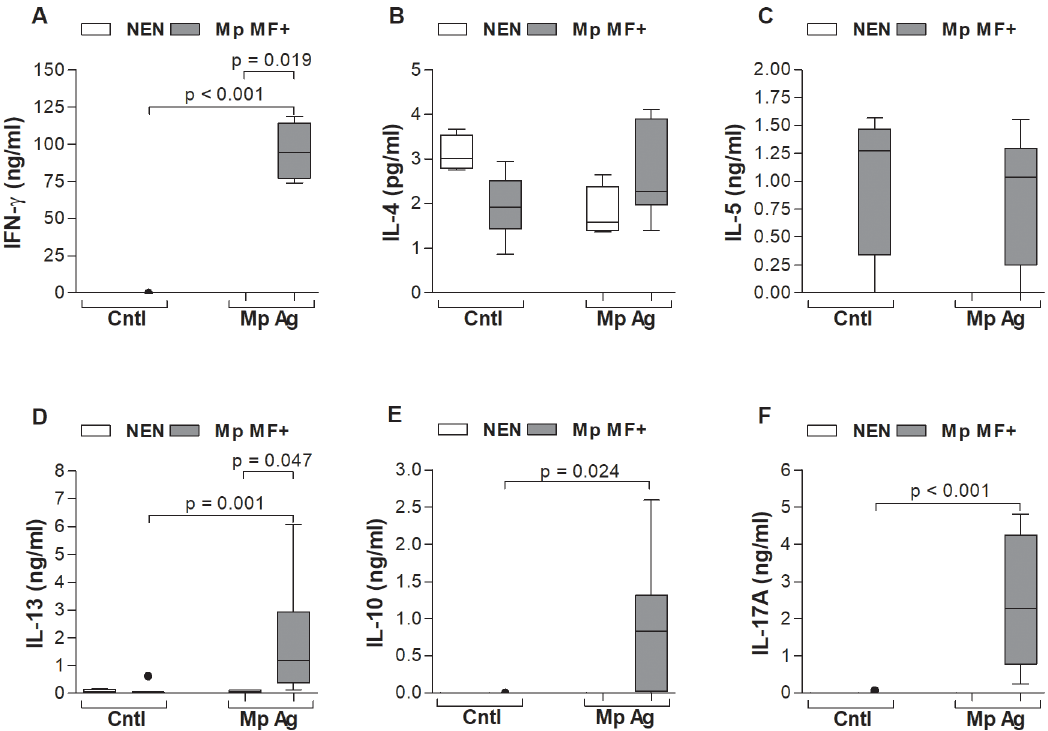
Fig 4. Dominant M . perstans -specific IL-10, IFN- γ , IL-13 and IL-17A production by peripheral cells from M . perstans microfilaremic individuals. Freshly isolated peripheral whole blood cells (100 μ l/well) from M . perstans microfilaremic individuals (Mp MF+; n = 9) and healthy European non-endemic normals (NEN; n = 4) were cultivated in 10% BCS/RPMI-1640 medium (100 μ l/well) and left either un-stimulated (Cntl) or cultured with M . perstans -derived worm antigen extract (Mp Ag, 50 μ g/ml) at 37˚C for 72 hours. Thereafter, culture supernatants were analysed for levels of ( A ) IFN- γ , ( B ) IL-4, ( C ) IL-5 ( D ) IL-13, ( E ) IL-10 and ( F ) IL-17A by ELISA. Graphs show box whiskers with median, interquartile ranges and outliers. Statistical significances between the indicated groups were obtained using the Kruskal-Wallis-test and, if significant, followed by a Dunn‘s multiple comparison test for further comparison of the